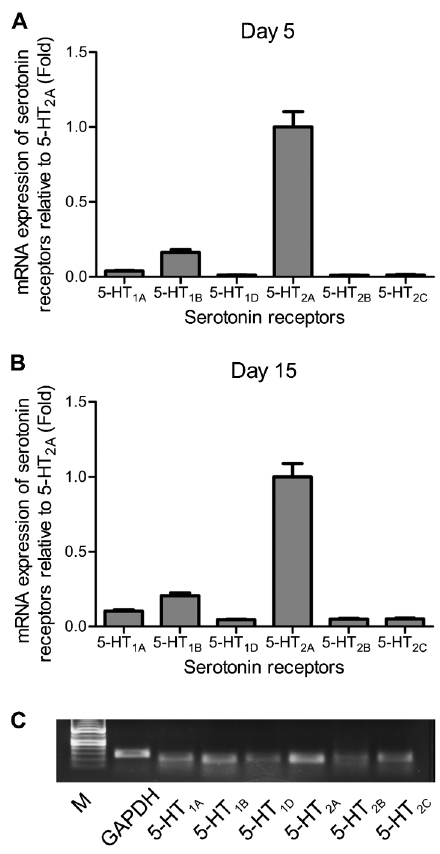
Figure 4. Expression profiles of 5-HT receptors in primary osteoblasts. Cells from the control group were harvested at day 5 ( A ) and day 15 ( B ) to assess the relative levels of mRNA expression of 5-HT 1A , 5-HT 1B , 5-HT 1D , 5-HT 2A , 5-HT 2B , and 5-HT 2C receptors. Electrophoresis on agarose/TAE gel further confirmed the presence of 5-HT receptors and amplification specificity ( C ). M: marker; GAPDH: glyceraldehyde-3-phosphate